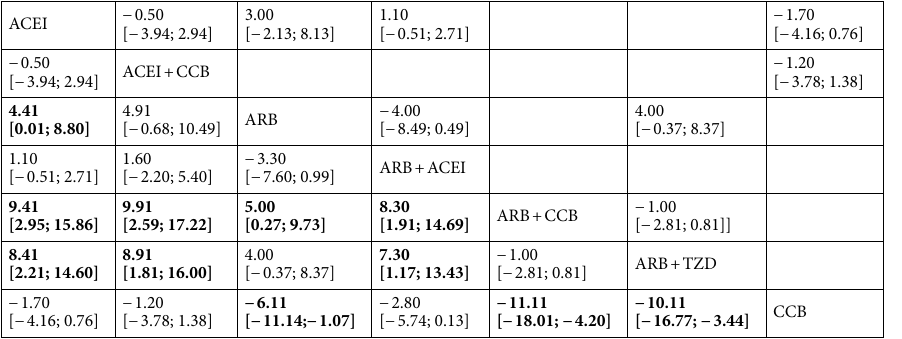
ACEI − 0.50 [− 3.94; 2.94] 3.00 [− 2.13;